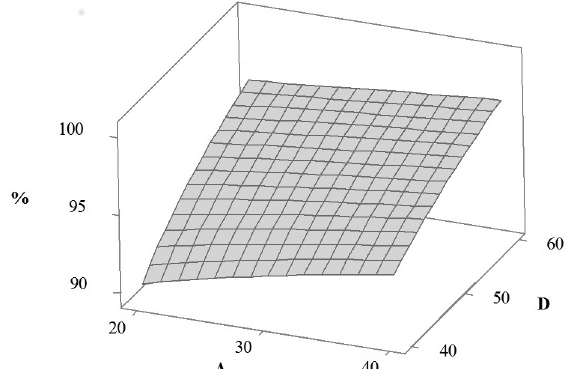
FIGURE 4 - Response surface plot of the effect of time of dissolution (A) and rotation speed (D) on the amount of acetaminophen dissolved (%).